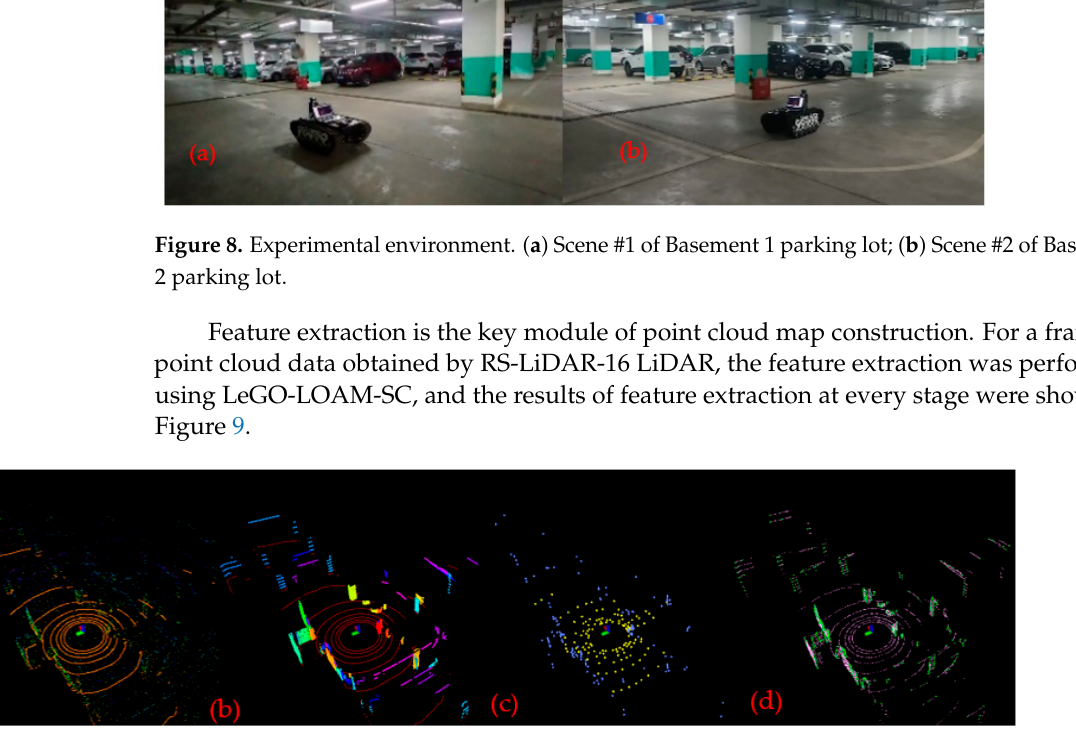
Figure 9. The results of feature extraction at every stage. ( a ) The original point cloud collected by LiDAR; ( b ) the ground points (in red) and the segmentation points (in others) after point cloud segmentation; ( c ) the edge feature points set n F e (in blue) and the plane feature points set n F p (in orange); ( d ) the edge feature F e (in green) and the plane feature F p (in pink).